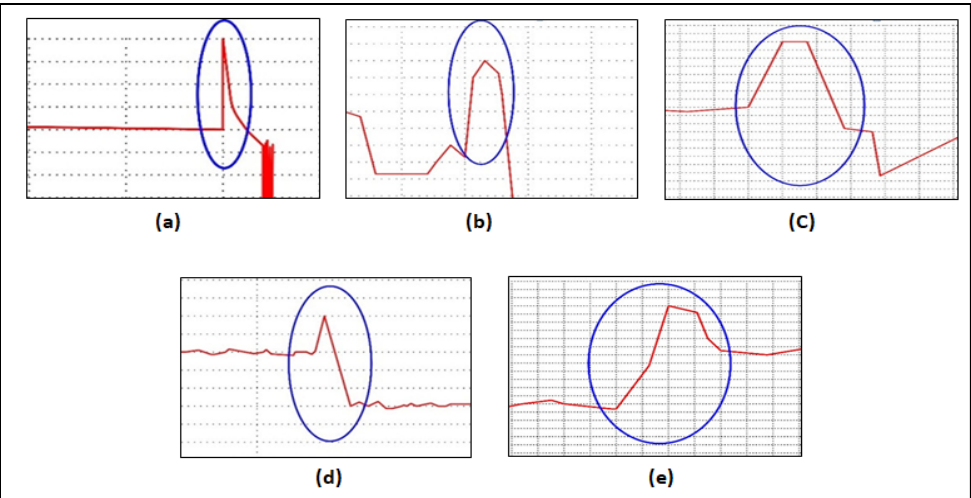
Figure 14. Pattern of the reflected test signals during fiber line detection.